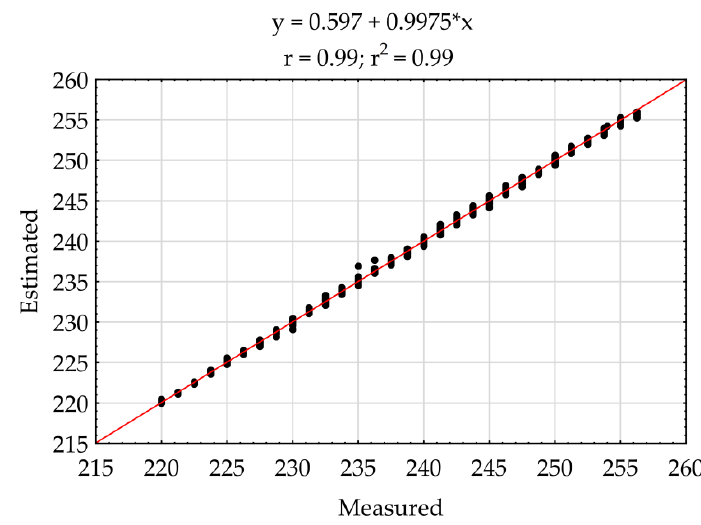
Figure 10. Correlation of the measured point data with the estimated data for the Krzemionki mining area and its surroundings.